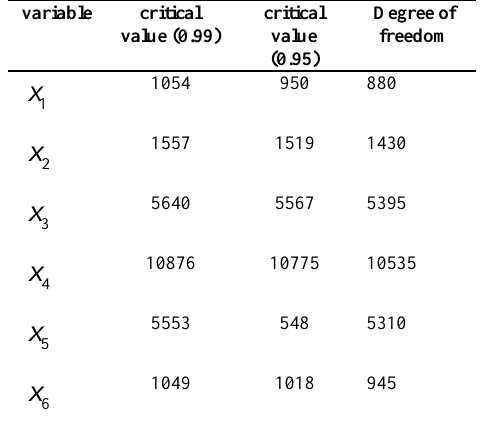
Table 7. Critical values for Chi-squared with respect to degree of freedom.